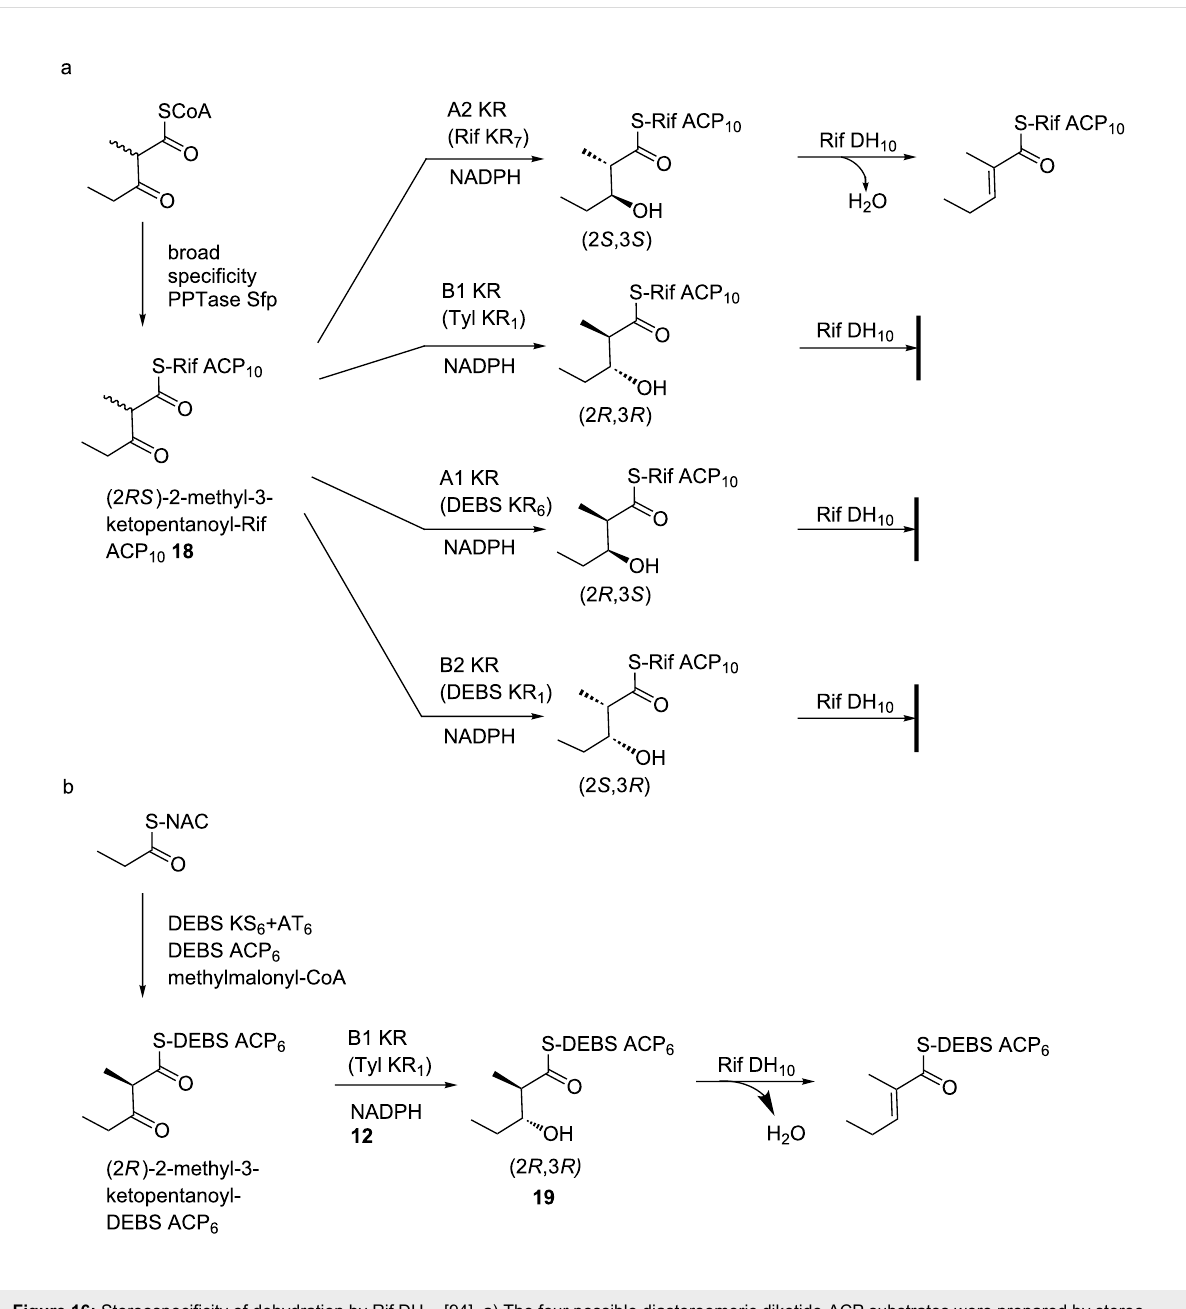
Figure 16: Stereospecificity of dehydration by Rif DH 10 [94]. a) The four possible diastereomeric diketide-ACP substrates were prepared by stereo- specific C-3 reduction (and C-2-methyl epimerization in the case of the A2 and B2-type KRs) of (2 RS )-2-methyl-3-ketopentanoyl-Rif ACP 10 . Only the substrate bearing (2 S ,3 S )-2-methyl-3-hydroxy stereochemistry was accepted as substrate by Rif DH 10 , yielding the trans double bond isomer. b) The alternative (2 R ,3 R )-2-methyl-3-hydroxy substrate was prepared on DEBS ACP 6 via condensation of propionyl and methylmalonyl building blocks by KS 6 , followed by stereospecific reduction by Tyl KR 1 . Syn dehydration again yielded the trans double